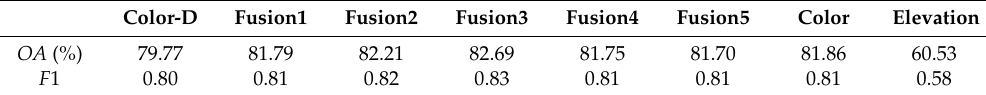
Figure 5. The contribution of layers 2, 3, 4 for different classes in elevation data: ( a ) Layer 2 contributes to impervious surfaces and low vegetation. When layer 2 is removed, they are no longer classified correctly; ( b ) shows the contribution of layer 3 for trees. Without layer 3, trees are mostly not detected anymore; ( c ) when layer 4 is removed, the results are noisy. Trees and low vegetation are not correctly classified; ( d ) without layer 5, large parts of buildings are not detected anymore. Table 3. Overall Accuracy ( OA ) for dataset